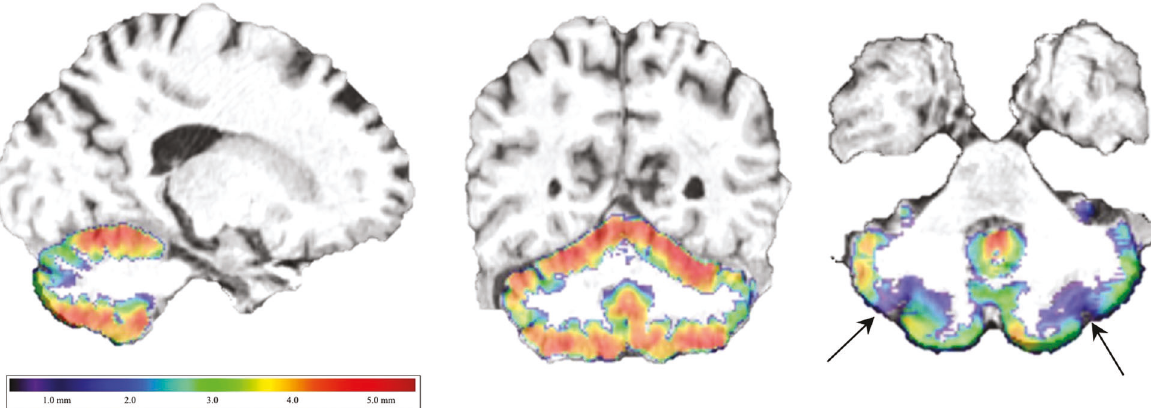
Fig. 1 Cerebellar cortical thickness map. Example of sagittal and coronal cerebellar cortical thickness estimate maps employed in this present study using a rainbow colormap to visually identify regional asymmetry in cortical thickness, such as in the cerebellar crus in this example of a responder with Cognitive